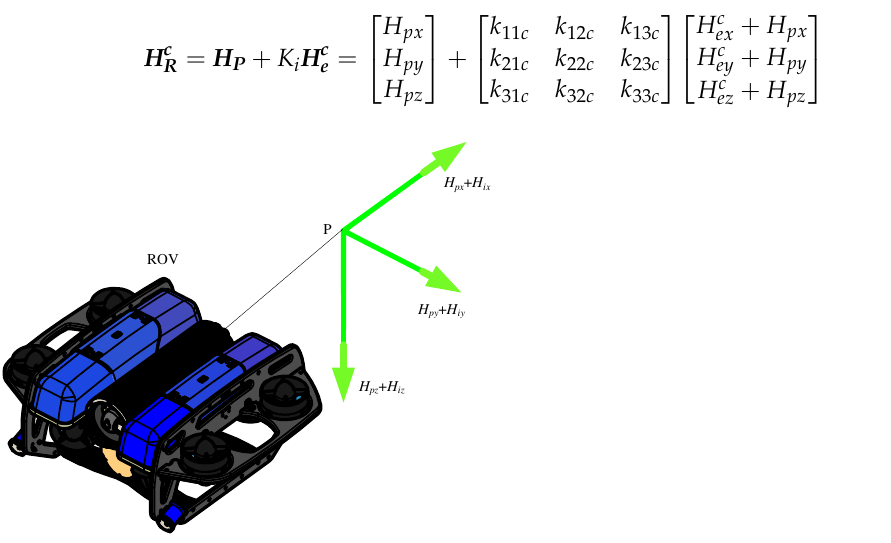
Figure 1. ROV’s static interference magnetic field in the point P. According to the literature [32], when the ROV’s thruster rotates, the thruster will gener- ate a leakage magnetic field with a sinusoidal periodic distribution. The static interference magnetic field of the ROV described above and the geomagnetic field change very slowly compared with the leakage magnetic field. Therefore, the data collector uses low-pass filtering to remove the high-frequency leakage magnetic field in the measured magnetic field signal in this experiment. Then, the filtered magnetic field measurement results are saved and used in the subsequent compensation parameter evaluation process.